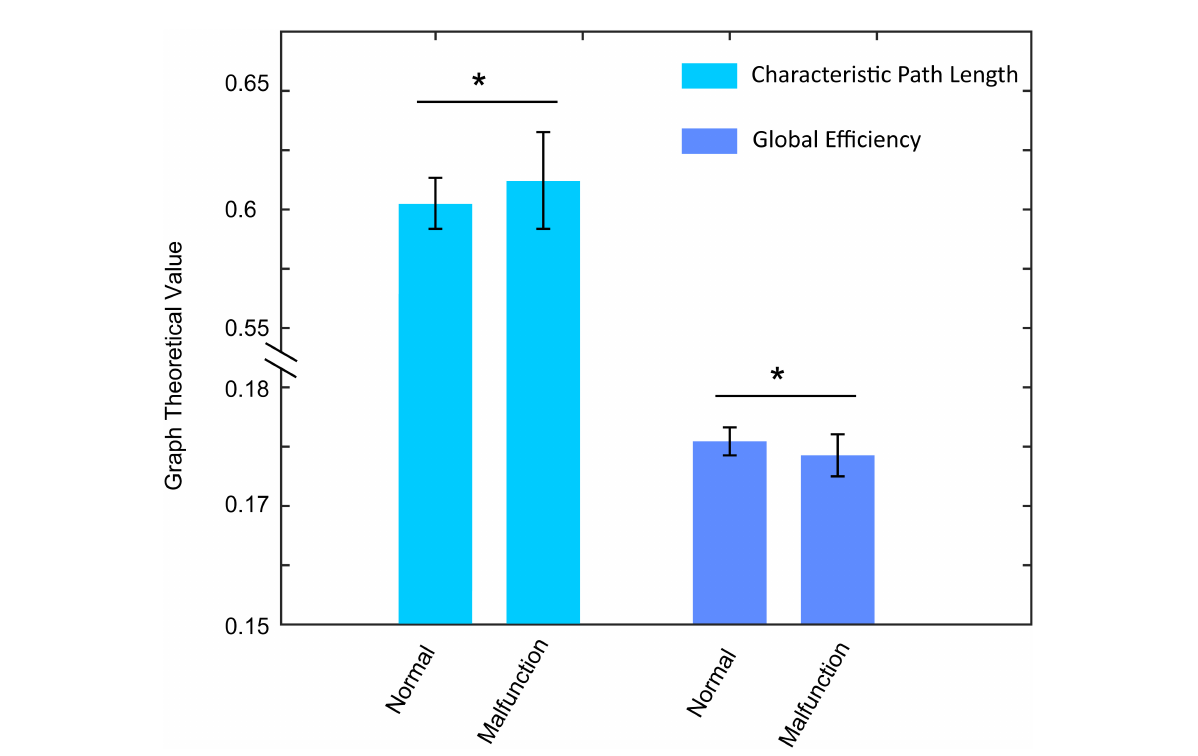
FIGURE4 The local efficiency and clustering coefficient alterations between normal condition and malfunction condition in the CA condition. Both two indexes show significantly higher values in malfunction conditions. * p < 0.01.